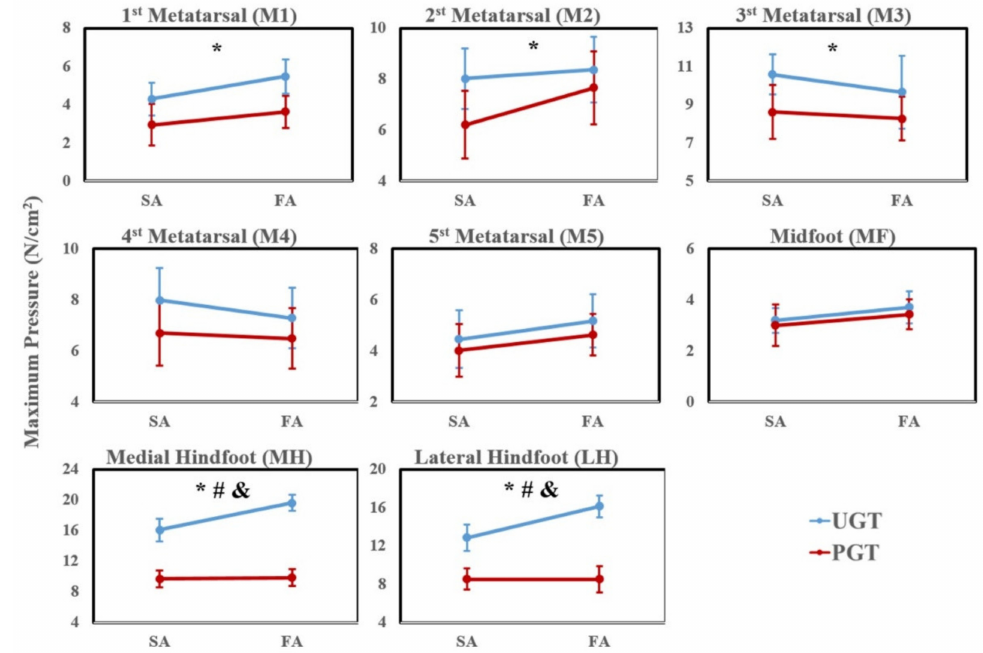
Figure 3. The plantar pressure during planned and unplanned gait termination in stiff arches and flexible arches. Notes: * means the main effect of terminational pattern; # means the main effect of arch stiffness; & means